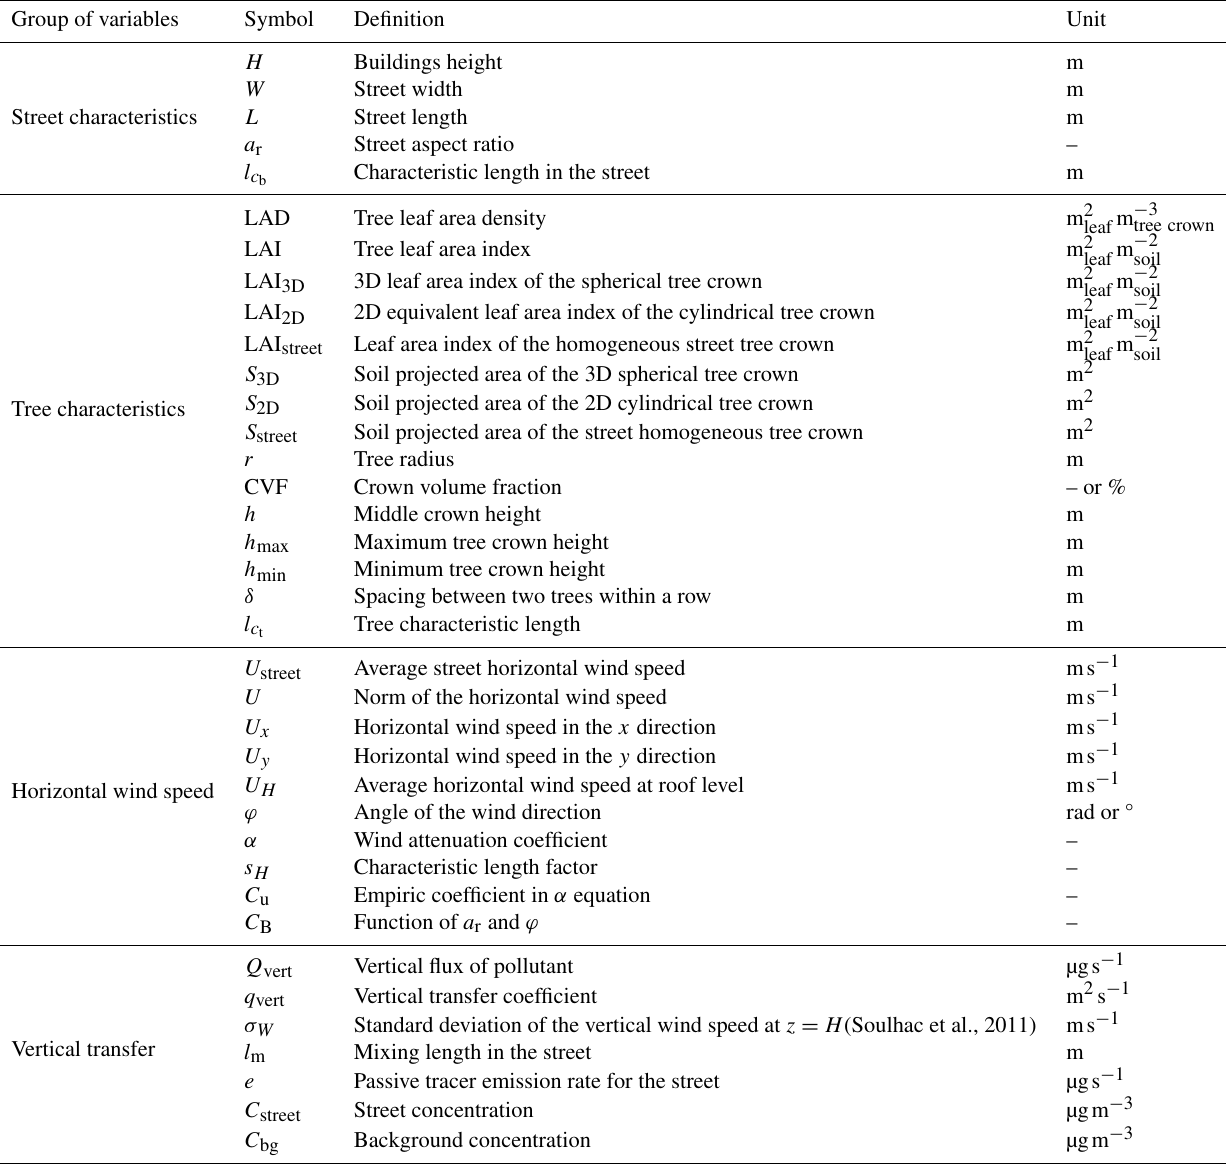
Table A3. List of variables. Group of